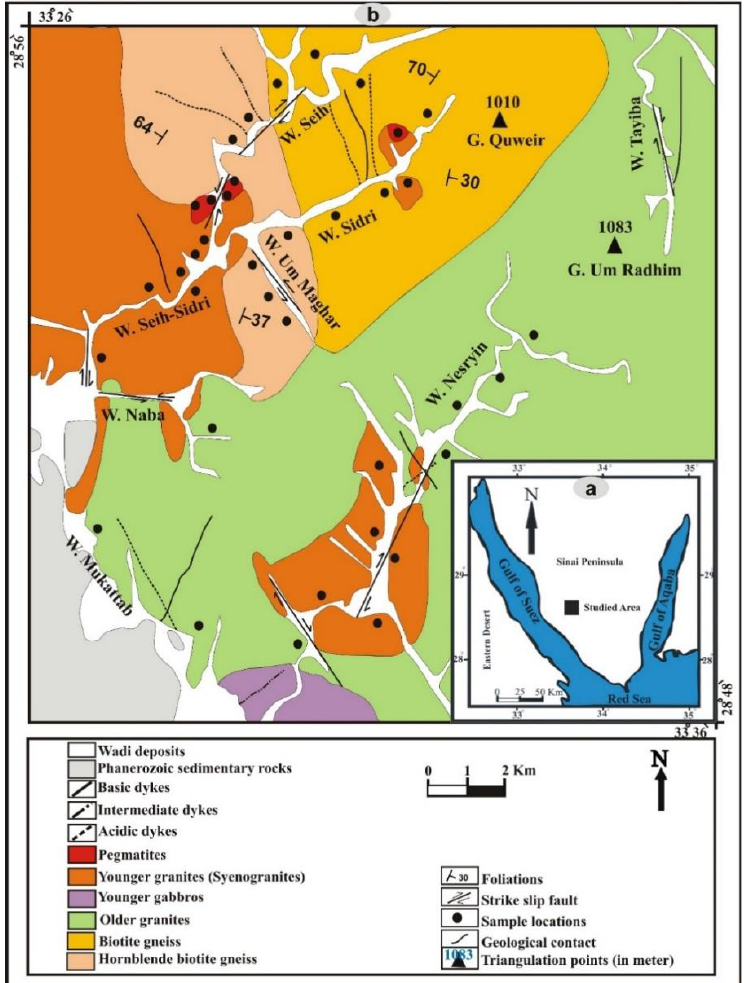
Figure 1. ( a ) Geographic map of Sinai, and ( b ) detailed geological map of Seih-Sidri area, southwest- ern Sinai, Egypt [34].